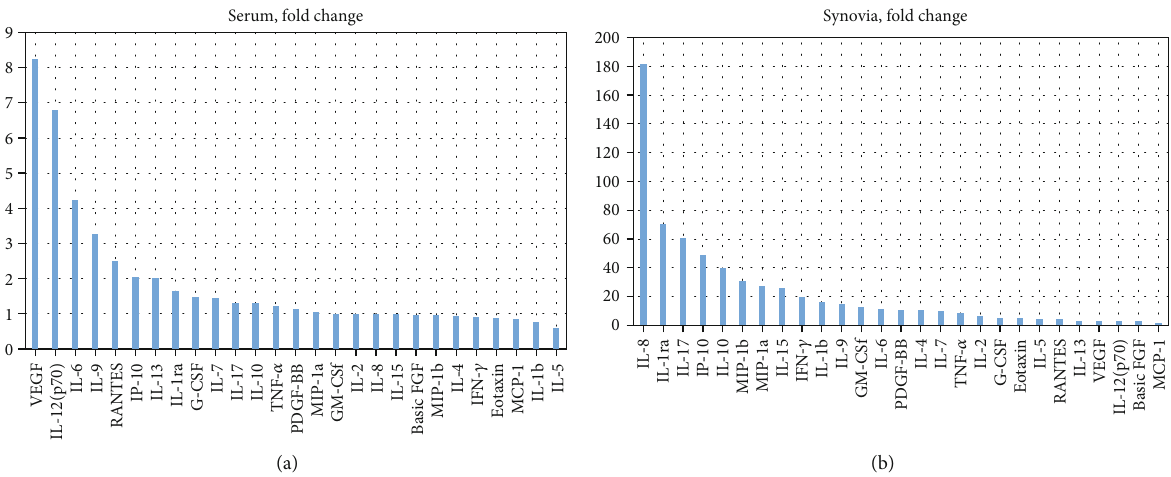
Figure 2: Fold changes of the mean cytokine concentrations between RA and control sample used for cell exposures. Panel (a) shows the fold change of mean cytokine concentration between the healthy controls and the treatment-naïve RA patient serums. Panel (b) shows the fold change of the mean cytokine concentrations between OA and RA synovial fl uid gathered at the time of prosthesis operation.